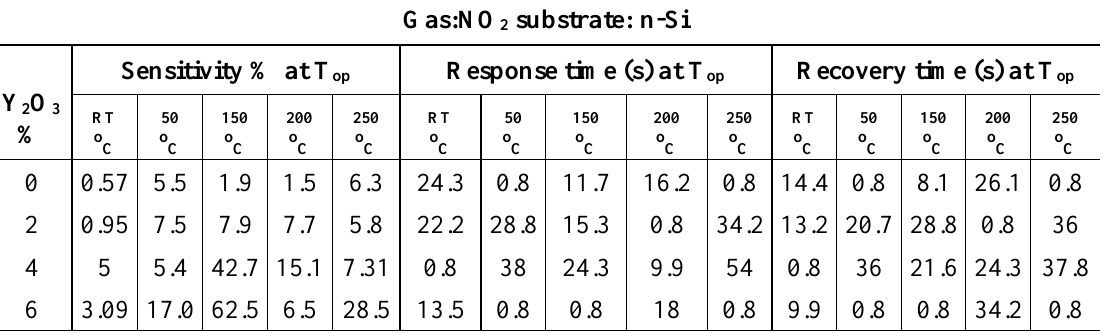
O and doped with 3 4 gas. 2